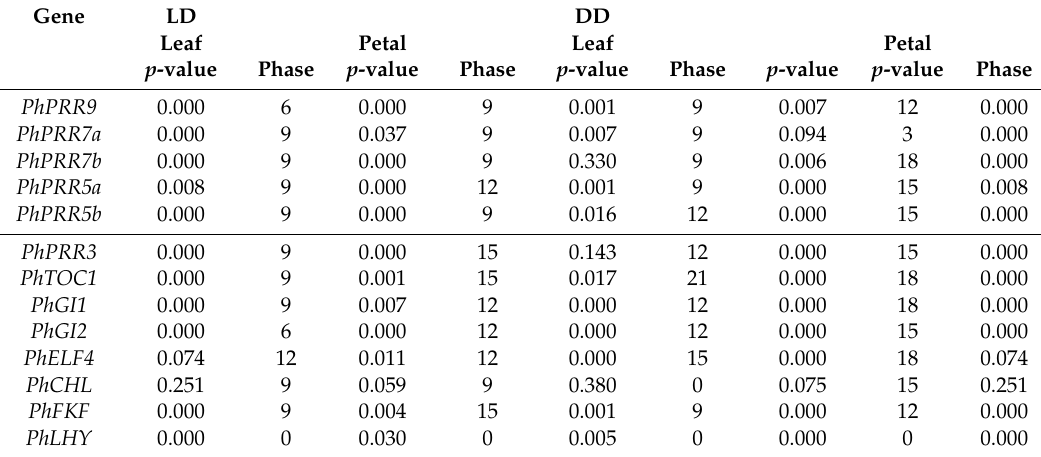
Table 1. Rhythmic analysis of transcriptional data. Detection of rhythmicity in petunia clock genes in leaves and petals under a light:dark cycle (LD) and constant darkness (DD). This analysis was performed with a non-parametric method implemented in the Bioconductor package “RAIN”. Significant p -values ( p < 0.05) indicate a robust oscillation. Phase denotes the time point with the maximum gene expression or